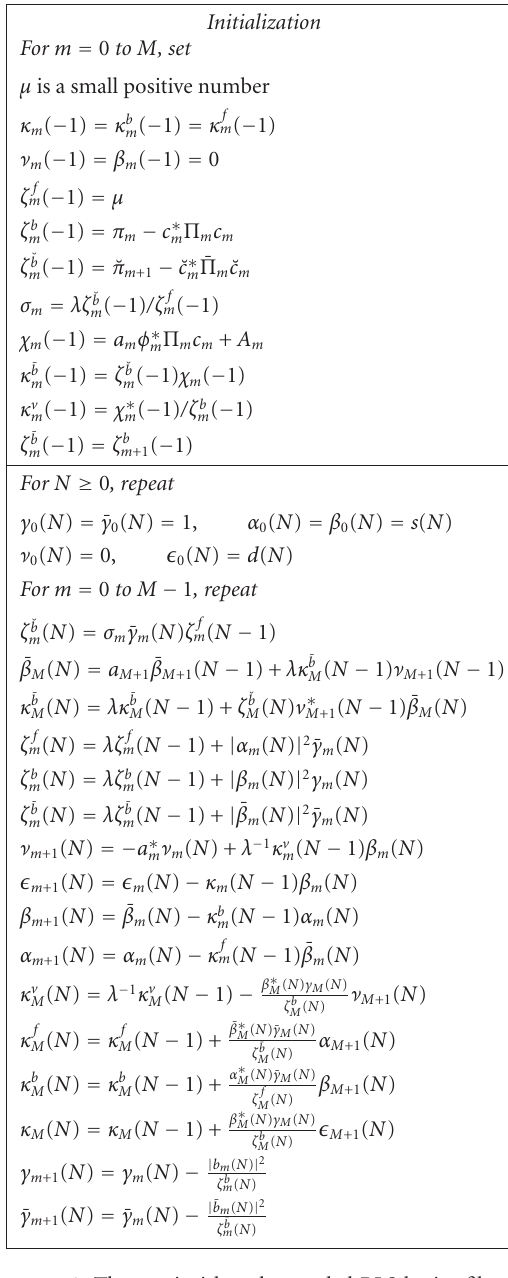
Algorithm 2: The a-priori-based extended RLS lattice filter with error